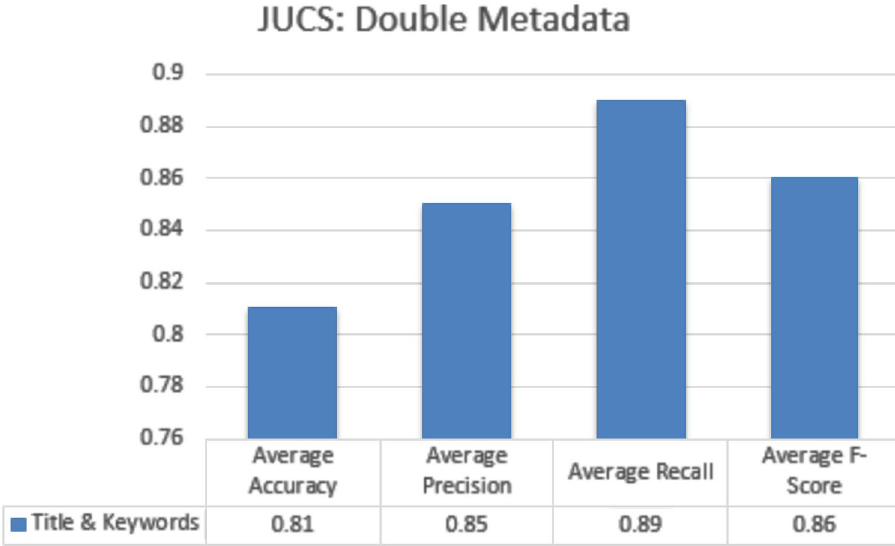
Figure 15. JUCS (double meta data).